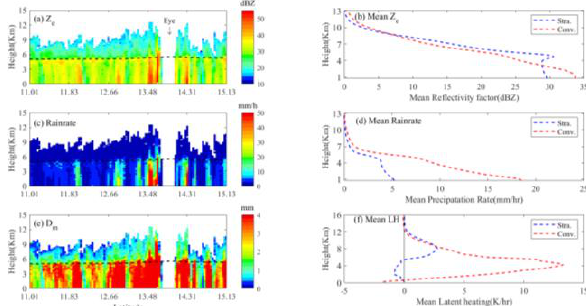
Figure 3. The vertical structure of precipitation and latent heating in Eye centre of “Mangkhut”. ( a), (c) and (e) present the vertical distribution of latitudinal-height for Radar reflectivity factor, Near-surface rainfall rate and Particle radius. ( b), (d) and (f) show the average-height vertical distribution of Radar reflectivity factor, Rainfall rate and Latent heating in terms of stratiform precipitation and convective precipitation. The position of the eye wall has been marked in the Figure 3 a. The black dashed line indicates the height of the zero-degree layer, and the average height of the zero-degree layer is 5.14